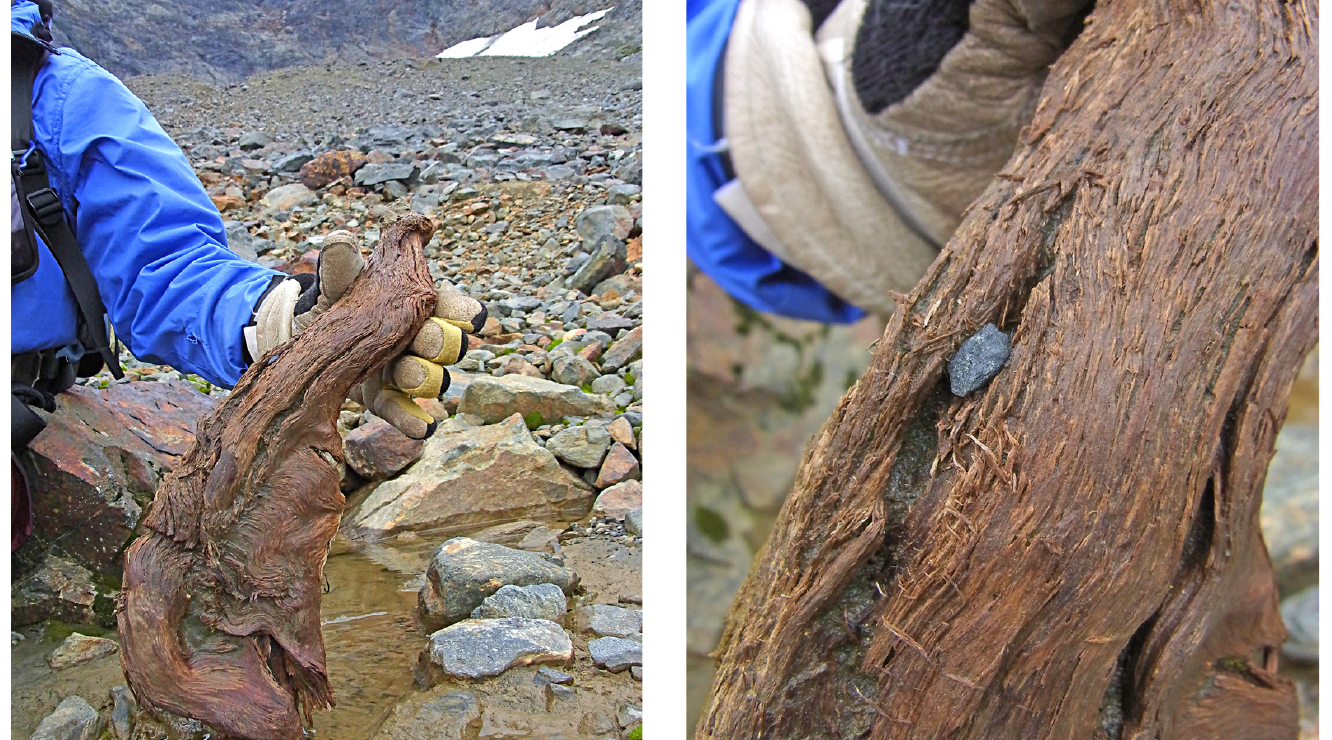
Figure 24: Ekorrglaciären (5). Piece of a pine trunk, with small pebbles pressed into the wood (right). 7590 cal. yr BP